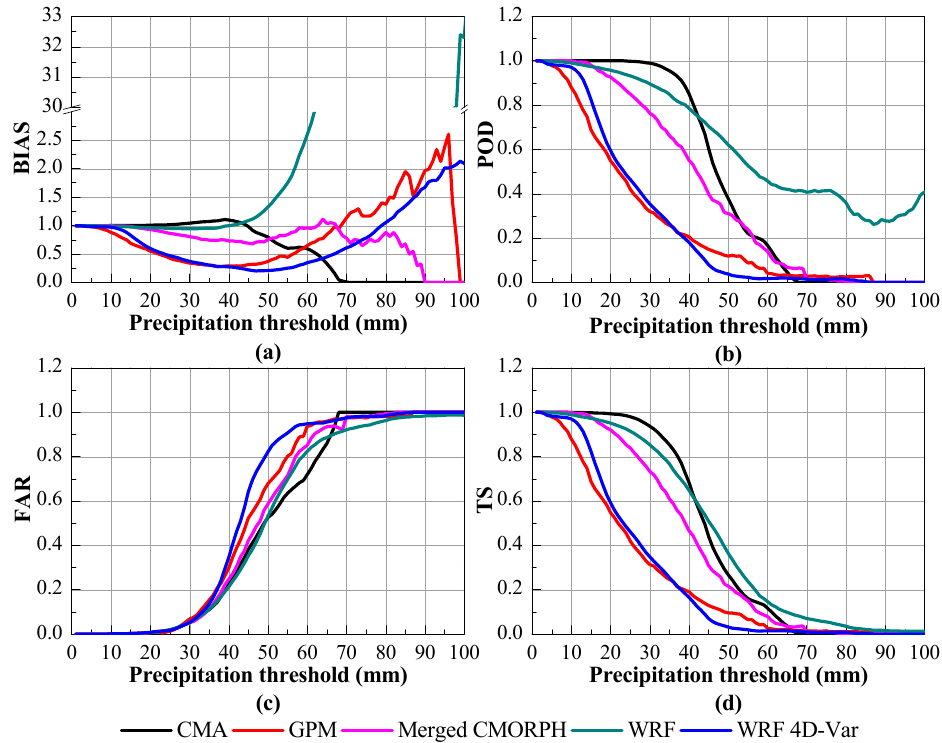
Figure 10. Skill scores of BIAS ( a ), POD ( b ), FAR ( c ) and TS ( d ) for the grid-scale evaluation of the accumulated heavy precipitation between the CMWR data and the other data from the CMA, GPM IMERG, merged CMORPH, WRF model and WRF 4D-Var system.